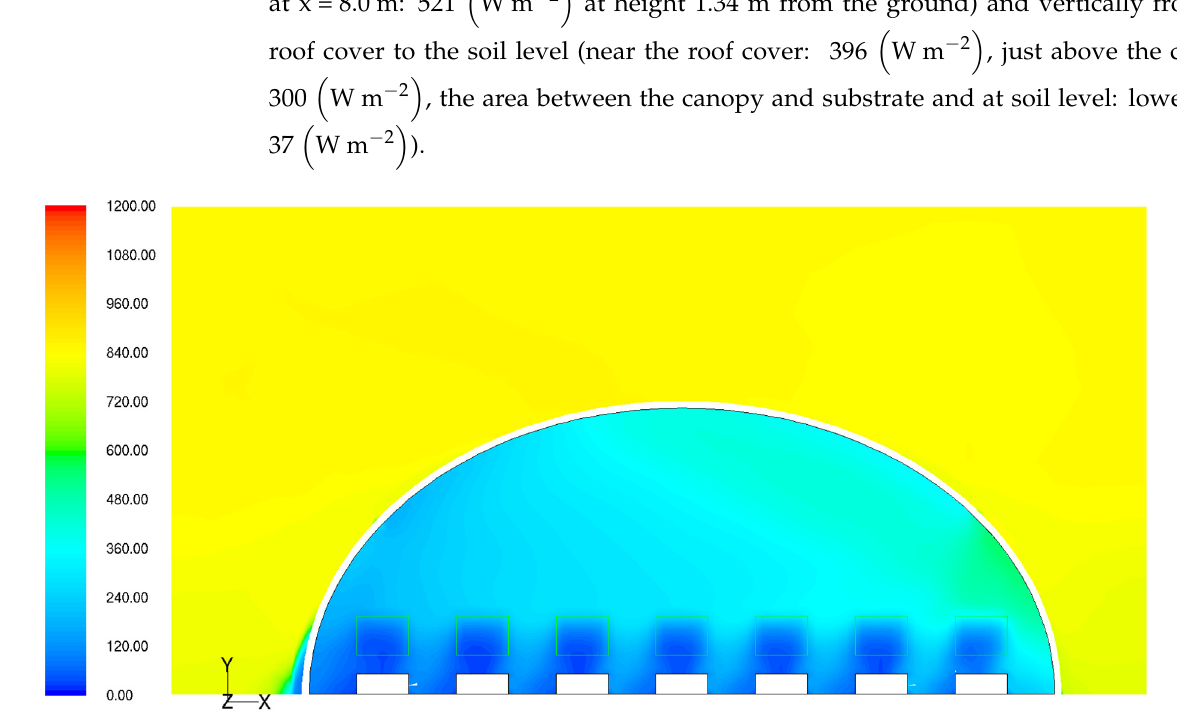
(cid:16) (cid:17) W m − 2 at a distance z = 19 m from the door of the